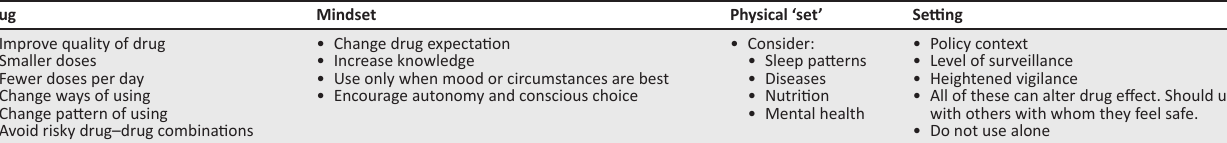
TABLE 3-A4: UNODC Stimulants guidelines counselling tips. 51,91